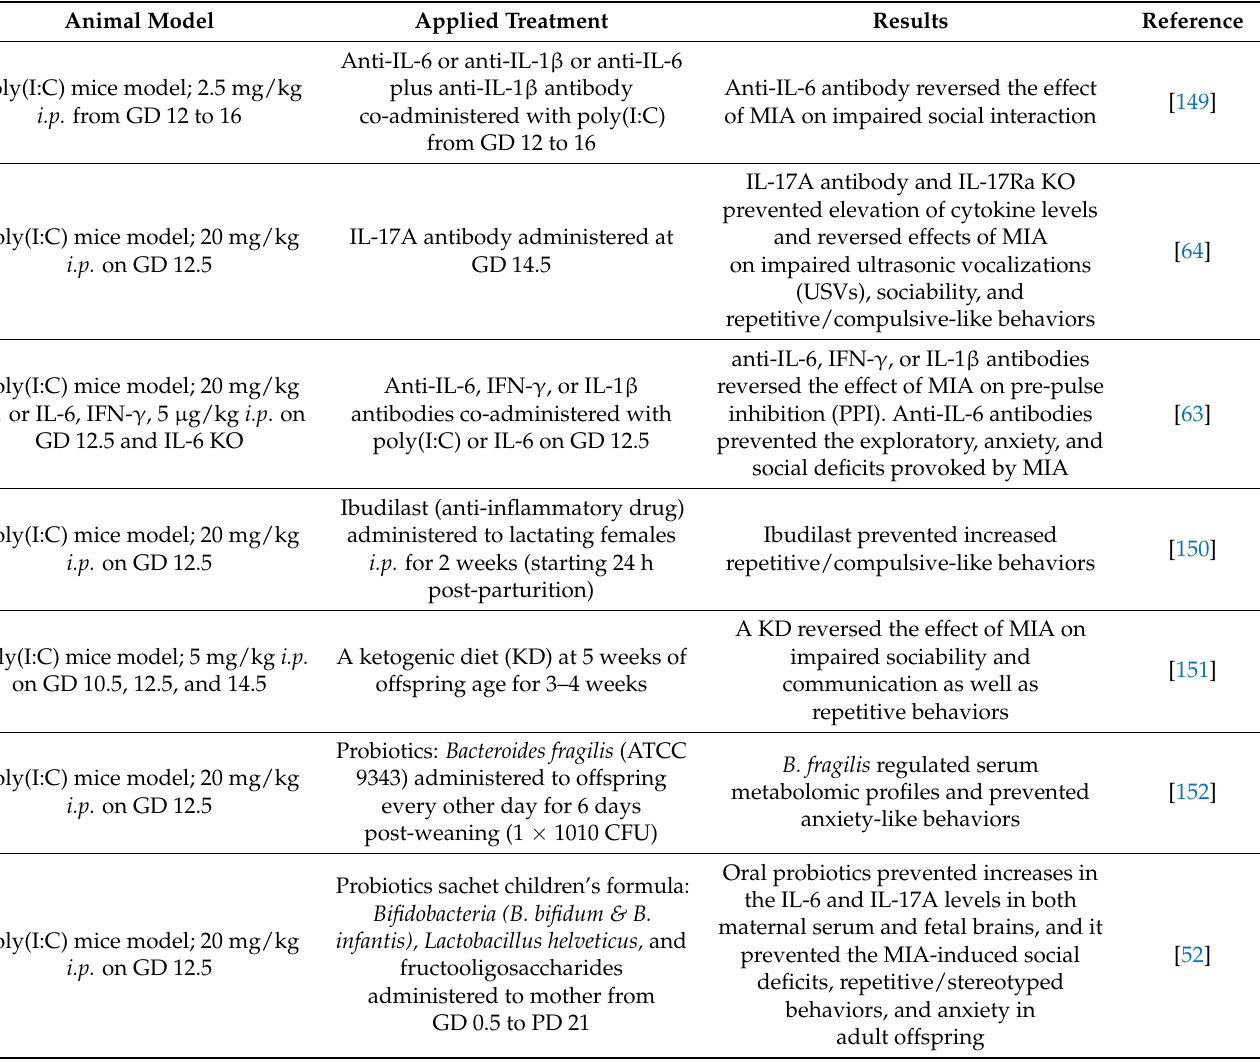
Table 1. The summary of the studies on potential therapeutic strategies for the MIA treatment.